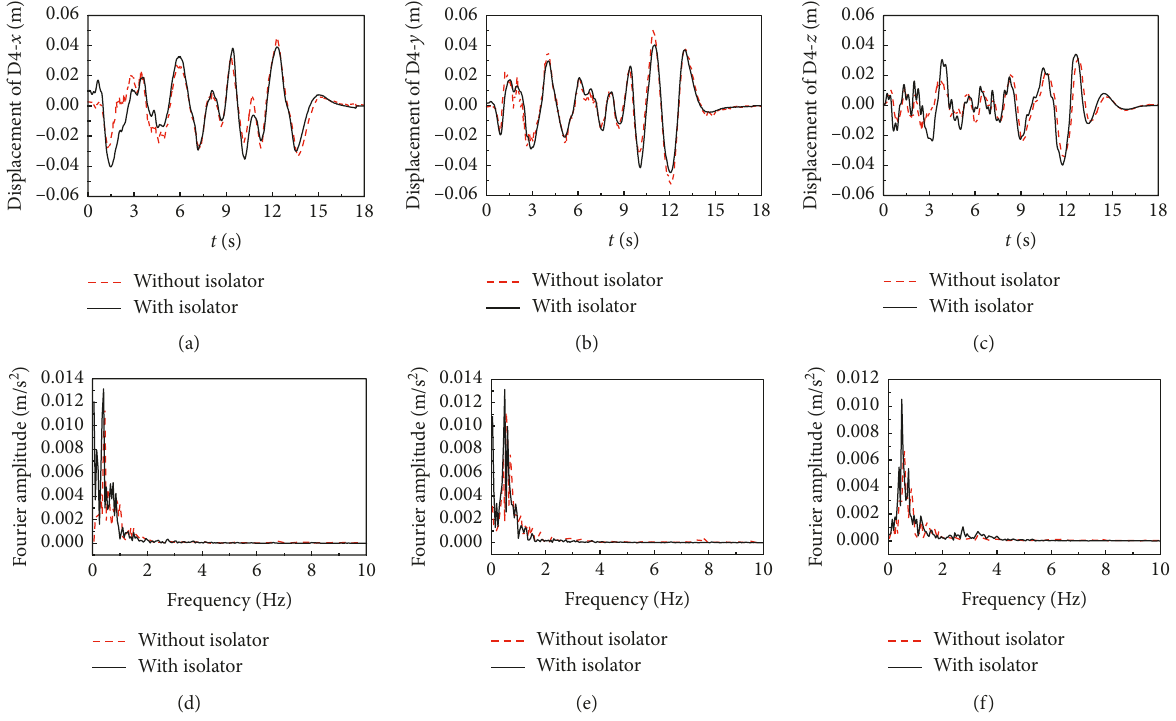
Figure 9: Response of displacement time history and its corresponding Fourier curve of D4 at top node. (a) Response of displacement of D4- x ; (b) response of displacement of D4- y ; (c) response of displacement of D4- z ; (d) Fourier curve of D4- x ; (e) Fourier curve of D4- y ; (f) Fourier curve of D4- z .